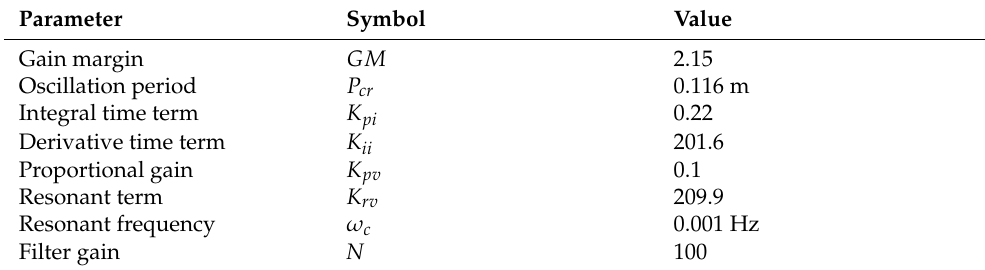
Table 3. Parameters for primary control.